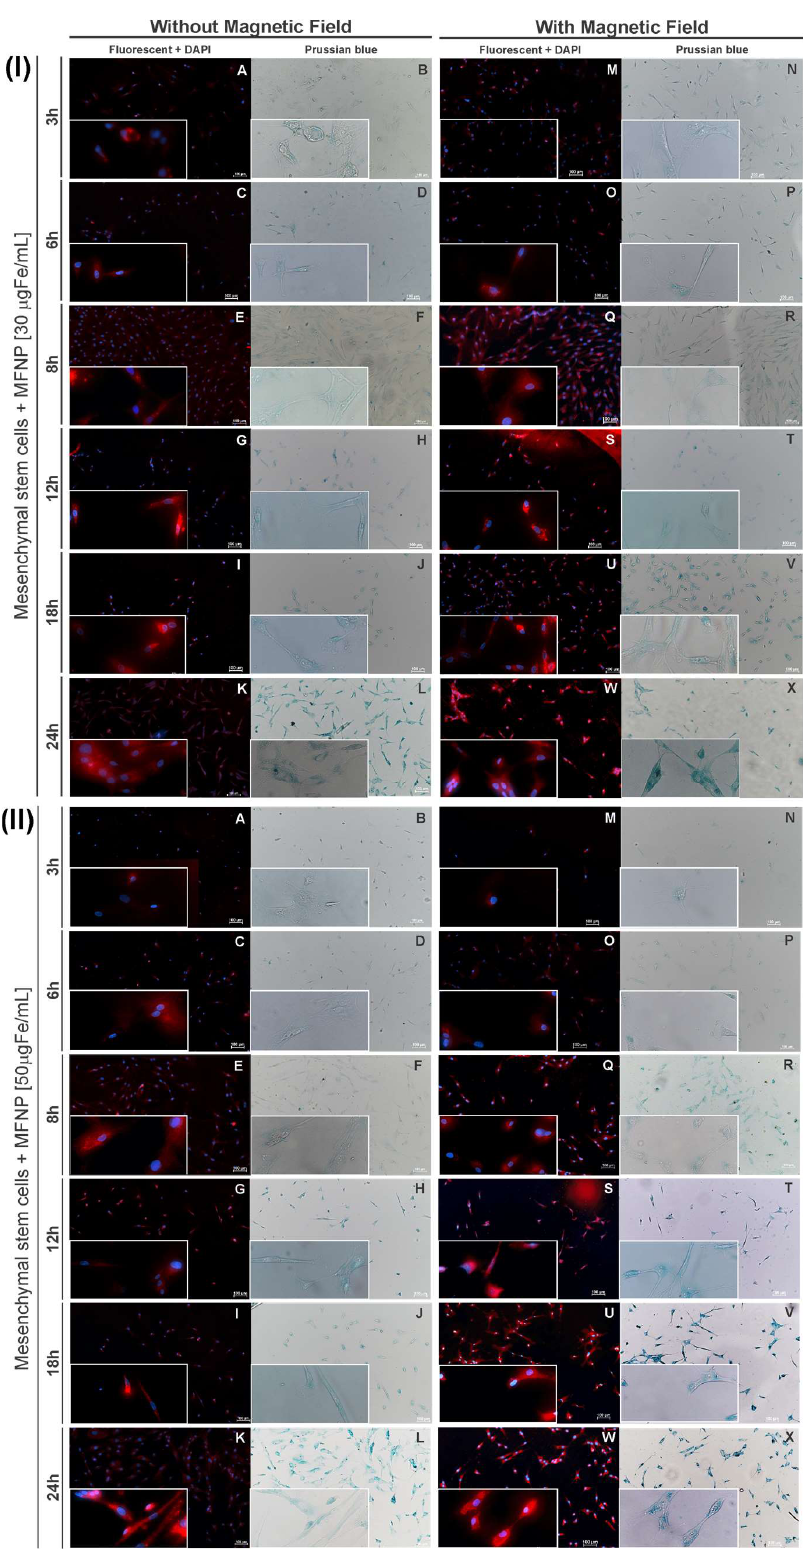
Figure 3. Microscopy images of MSC labeled with 30 ( I ) and 50 ( II ) µgFe/mL of multifunctional nanoparticles (MFNP) by fluorescence without a magnetic field ( A , C , E , G , I , K ) and with a magnetic field ( M,O,Q,S,U,W ). By brightfield without magnetic field ( B,D,F,H,J,L ) and with a magnetic field ( N,P,R,T,V,X ). Abbreviations: MFNP—Multifunctional nanoparticle; MSC—mesenchymal stem cell.